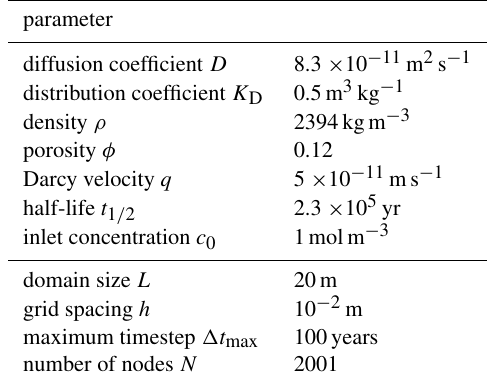
Table 2. The parameters used in the test (Van Genuchten, 1981), and the additional model parameters for the numerical treatment (bottom).